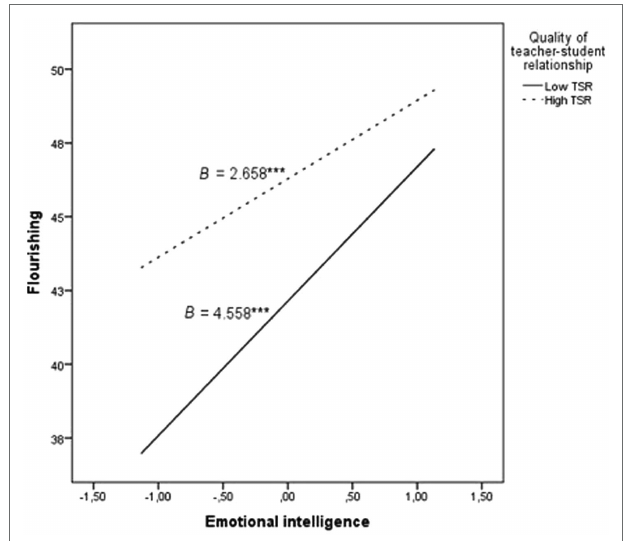
FIGURE 1 | Flourishing as a function of emotional intelligence at low ( M − SD) and high ( M + SD) levels of teacher-student relationship quality. B = unstandardized coefficients; *** p <